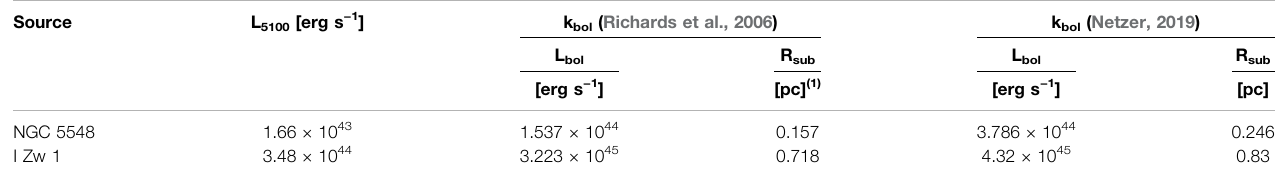
TABLE 2 | Estimates for dust sublimation radius for NGC 5548 and I Zw